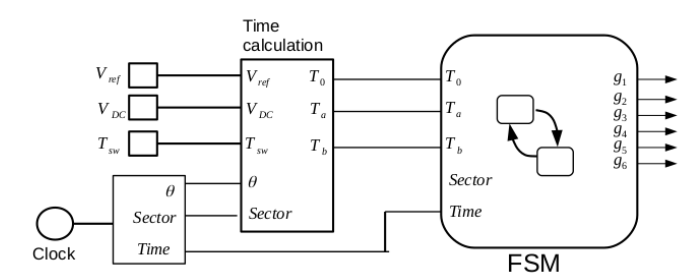
Figure 9. Switching control based on SVM-FSM.